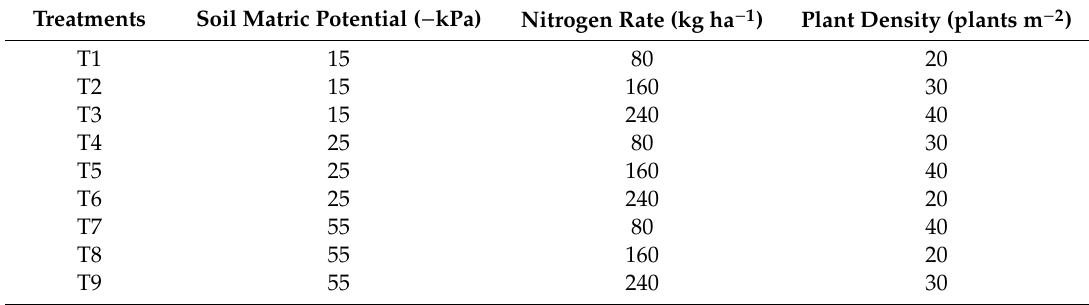
Table 2. Experimental treatments for quinoa production in 2018 and 2019. Treatments Soil Matric Potential ( − kPa) Nitrogen Rate (kg ha − 1